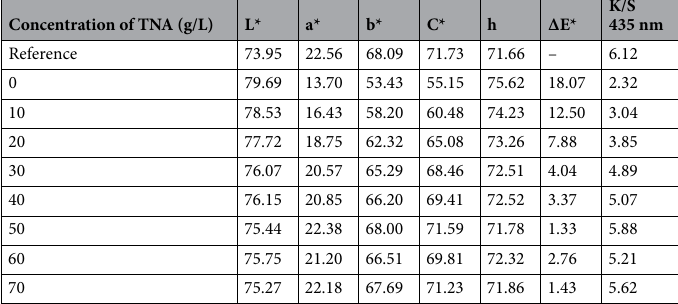
Concentration of TNA